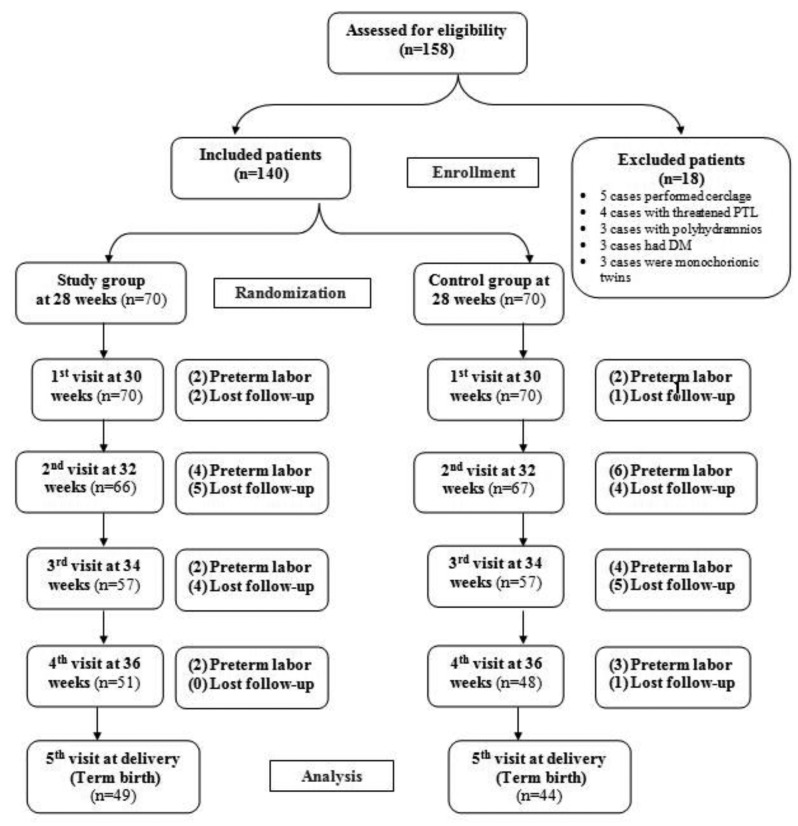
The study flowchart.